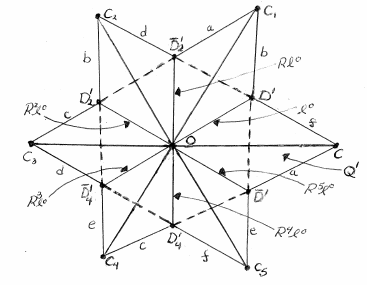
Figure 6. The triangulation T cl ( K ∗ ) of the regular stellated hexagon K ∗ . The vertices of cl( K ∗ ) are labeled X j = R j X for X = A , B , C and equivalent edges by a , b , c , d , e , f